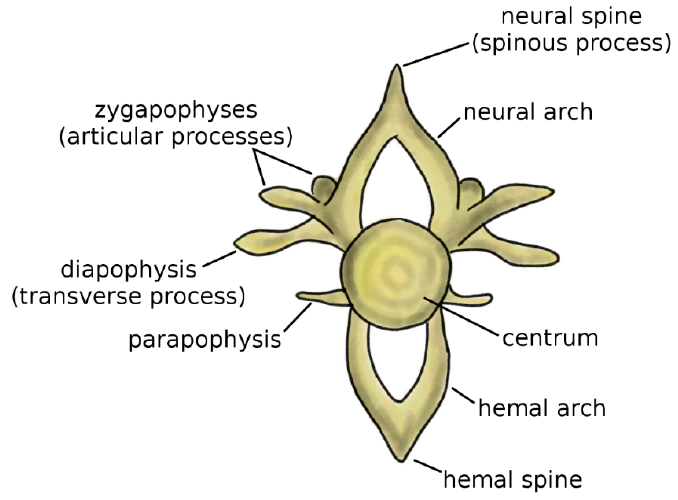
Figure 1. Schematic representation of a vertebra. Adapted from Reference [6].